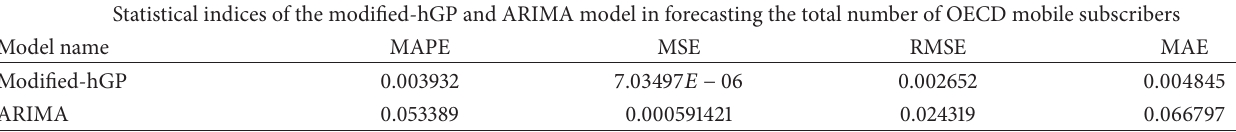
Table 11: Statistical indices in forecasting process of the modified-hGP and ARIMA model for the total number of OECD subscribers. Statistical indices of the modified-hGP and ARIMA model in forecasting the total number of OECD mobile subscribers